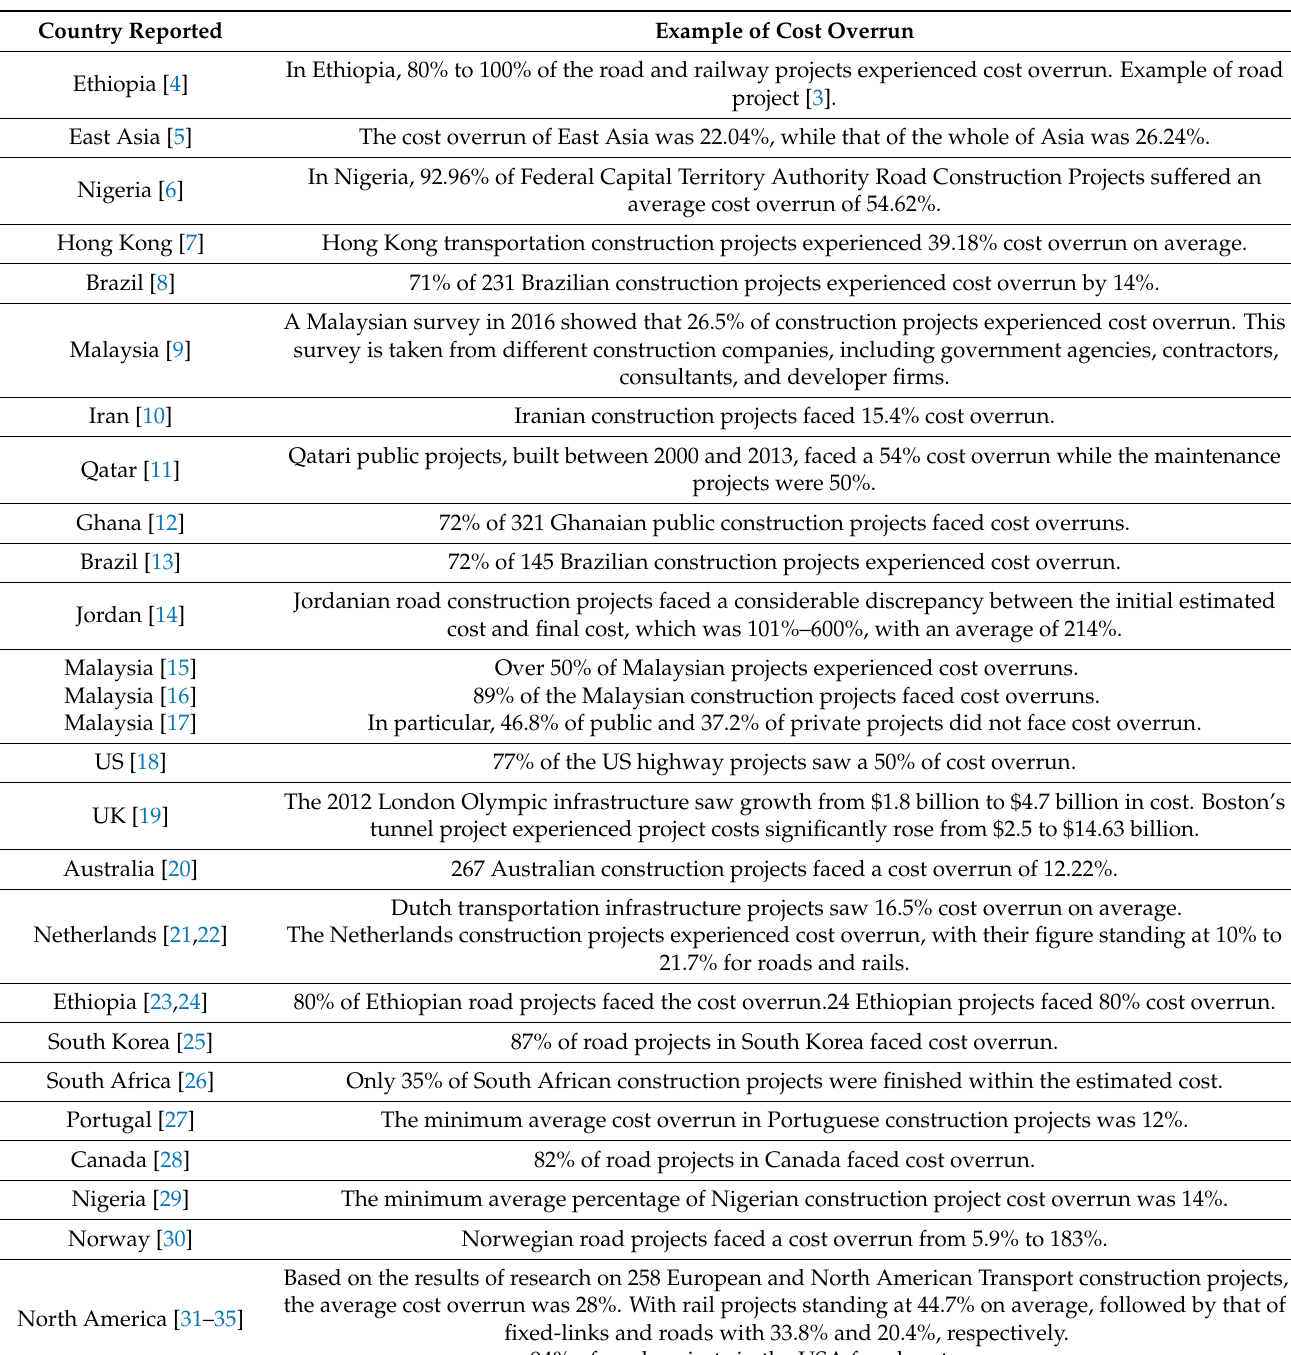
Table 1. Evidence of cost overrun in various projects or